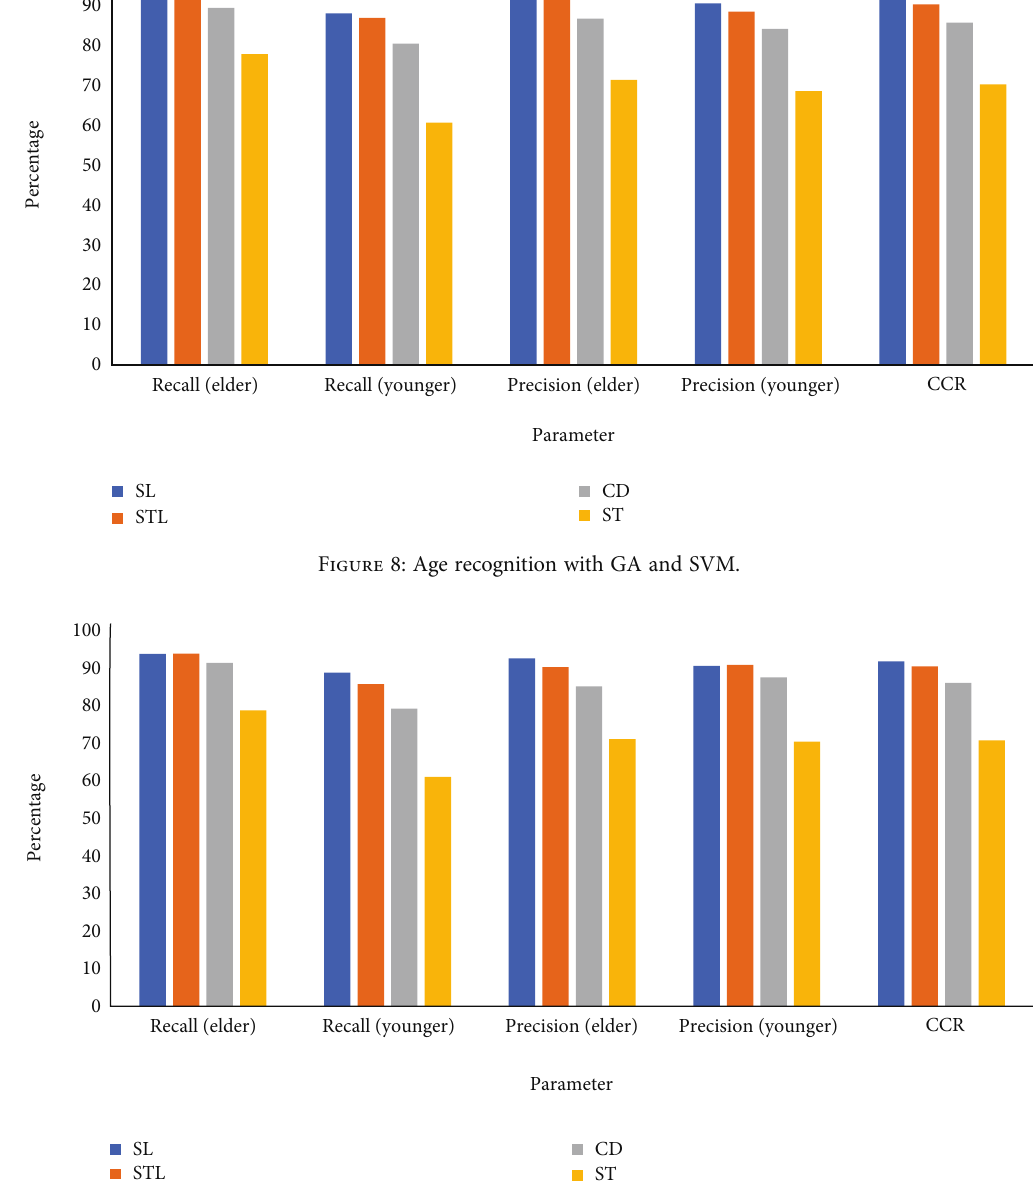
Figure 9: Age recognition with PSO and